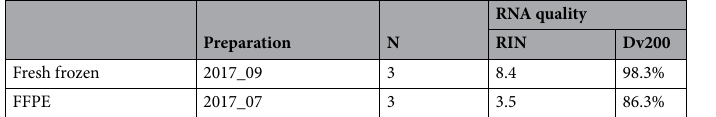
Table 1. Sample quality assessments. RIN RNA integrity number, Dv200 percentage of RNA fragments with more than 200